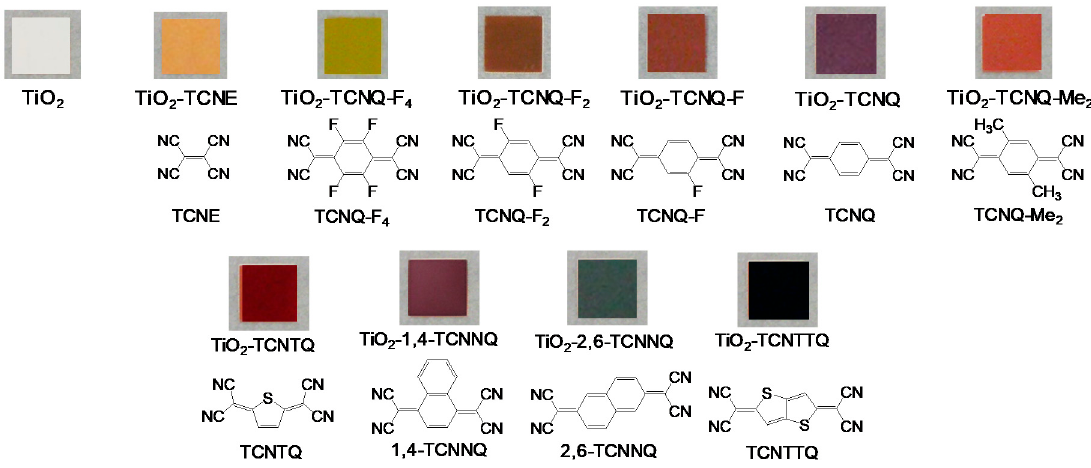
Figure 4. Photographs of anatase TiO 2 nanoparticles immersed in the solution of various TCNXs.